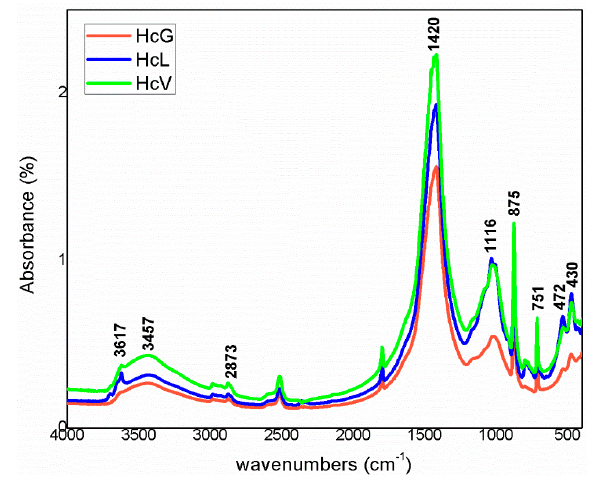
Figure 9. FTIR spectra for calcareous waste (Hc).